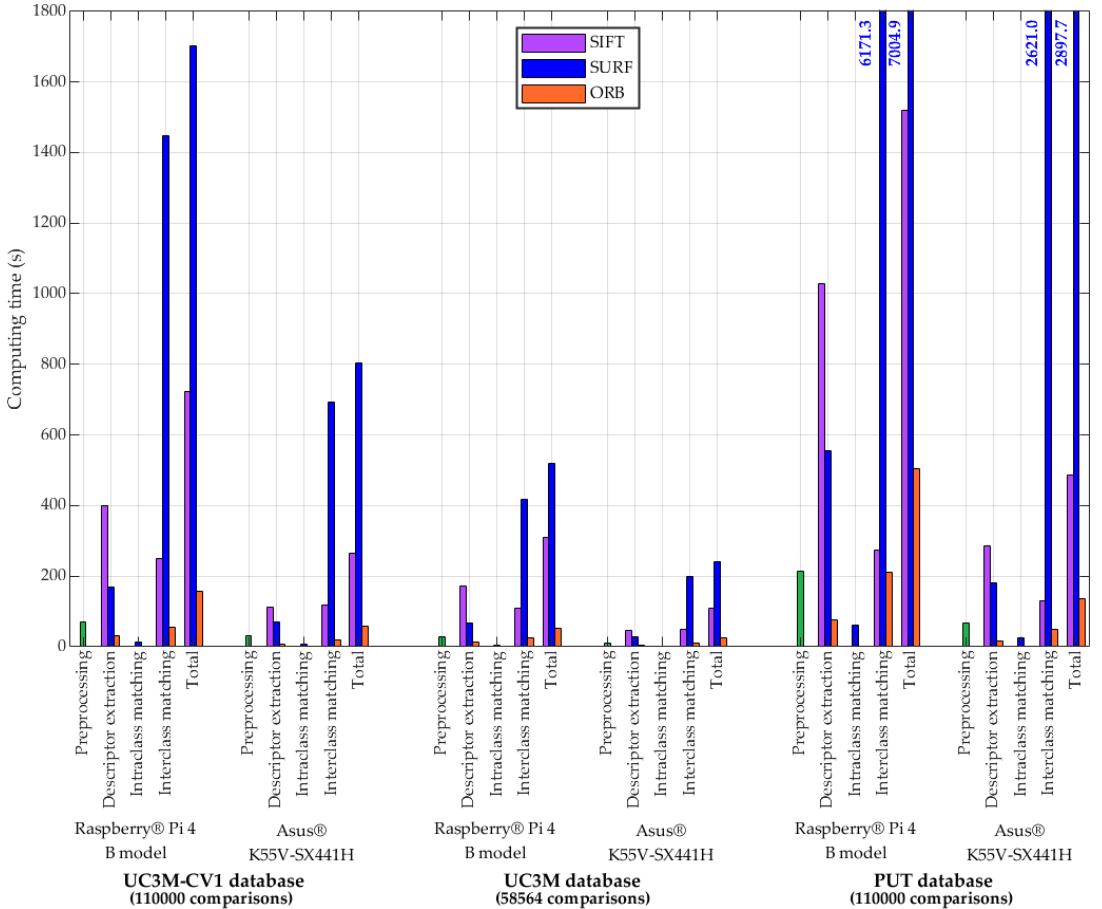
Figure 16. Results: Processing-time performance in seconds for each database and its computing hardware using TGS-CVBR ® and PIS-CVBR ® with SIFT ® , SURF ® , and ORB algorithms. Preprocessing time is in green color due to its independence with feature extraction algorithms.